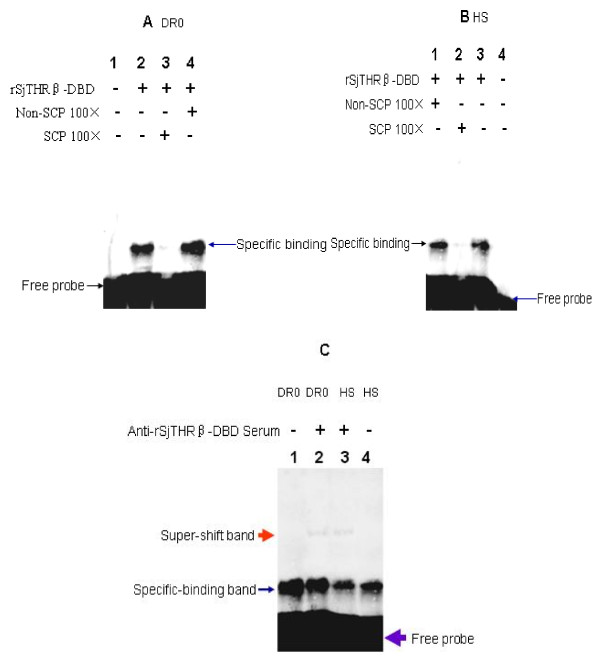
rSjTHRβ-DBD protein binds to Half-site and DR0 in vitro. ( A) Binding of rSjTHRβ-DBD protein to DR0. Lane1: Reaction mixture without rSjTHRβ-DBD as negative control. Lane2: Contains rSjTHRβ-DBD. Lane3: Contains rSjTHRβ-DBD with 100 fold of Specific competitive probe (SCP). Lane4: Contains rSjTHRβ-DBD with 100 fold of Non specific competitive probe (Non-SCP) ( B) Binding of rSjTHRβ-DBD protein to Half-site (HS). Lane1: Contains rSjTHRβ-DBD with 100 fold of Non specific competitive probe (Non-SCP). Lane2: Contains rSjTHRβ-DBD with 100 fold of Specific competitive probe (SCP). Lane3: Contains rSjTHRβ-DBD. Lane4: Reaction mixture without rSjTHRβ-DBD as negative control. ( C) Super-shift experiment. Lane1: Probe DR0 without anti-rSjTHRβ-DBD Serum. Lane2: Probe DR0 with anti-rSjTHRβ-DBD Serum. Lane3: Probe HS with anti-rSjTHRβ-DBD Serum. Lane4: Probe HS without anti-rSjTHRβ-DBD Serum.